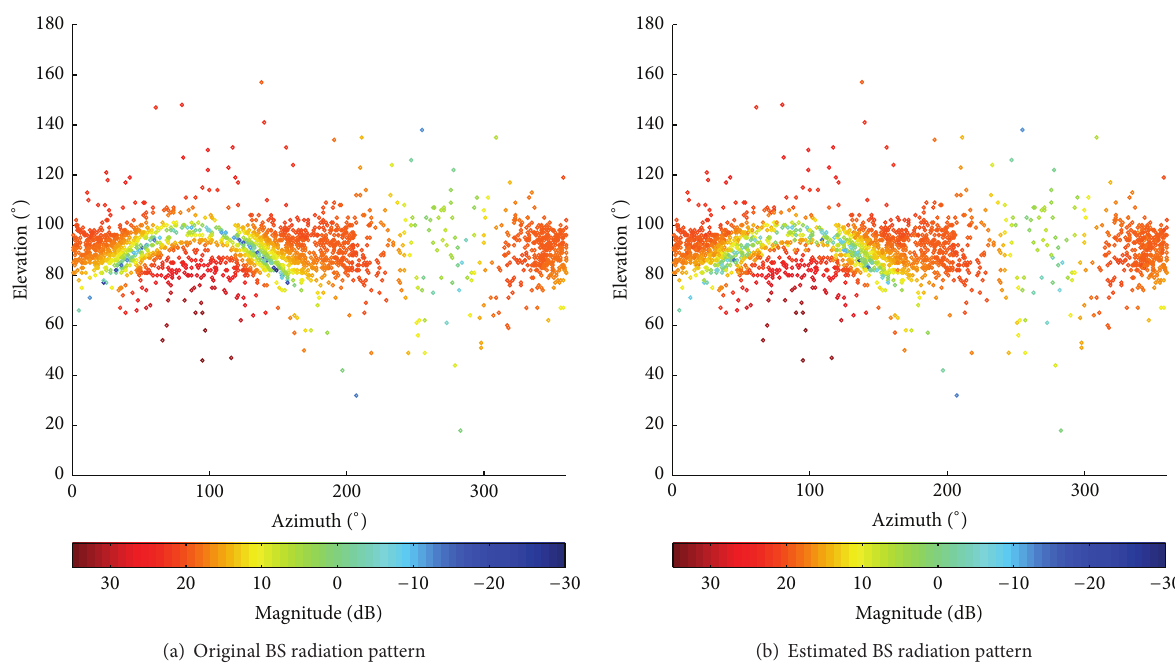
Figure 8: The original and estimated BS antenna radiation patterns.